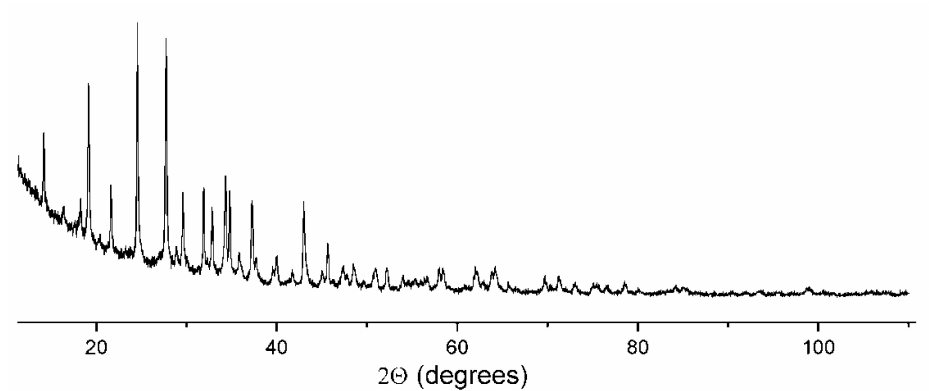
Figure 32. Powder X-ray diffraction pattern of the product of Experiment 3. All reflections correspond to a cancrinite-type